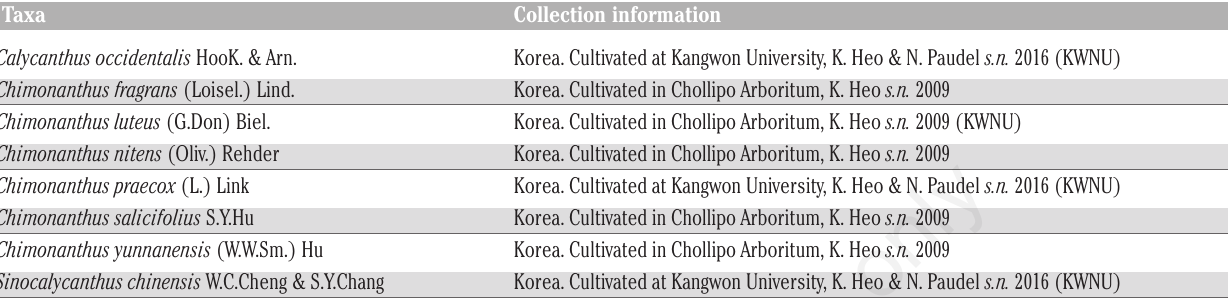
Table 2. Seed morphology and measurement.